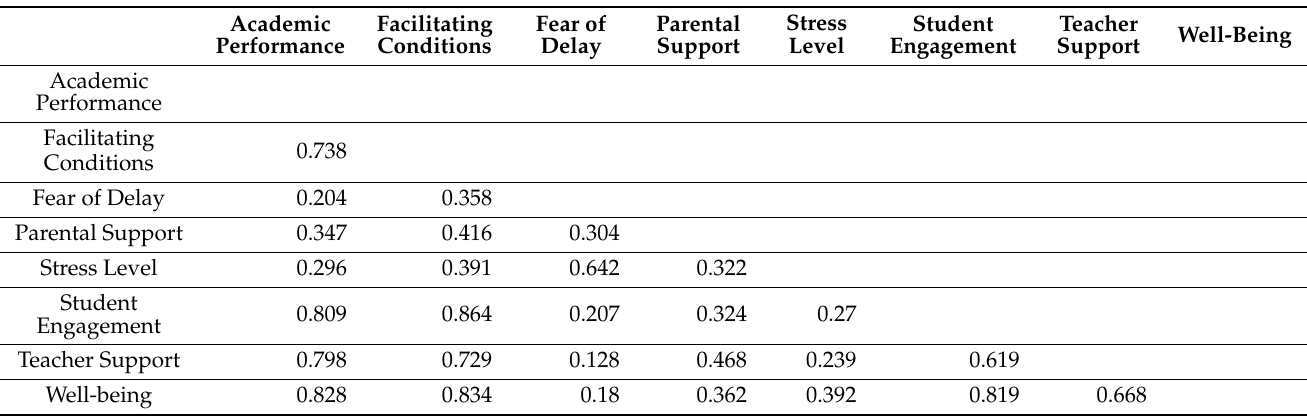
Table 5. Results of the HTMT test for assessing discriminant